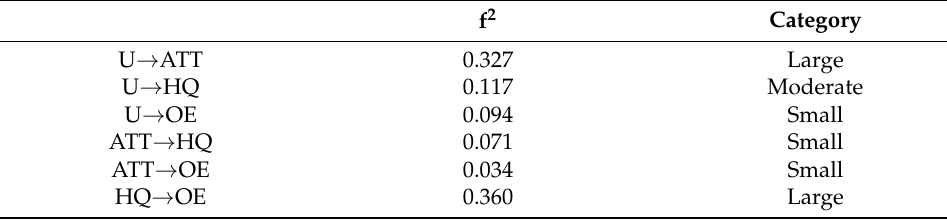
Table 6. Values of f 2. Table 7. PLS predict